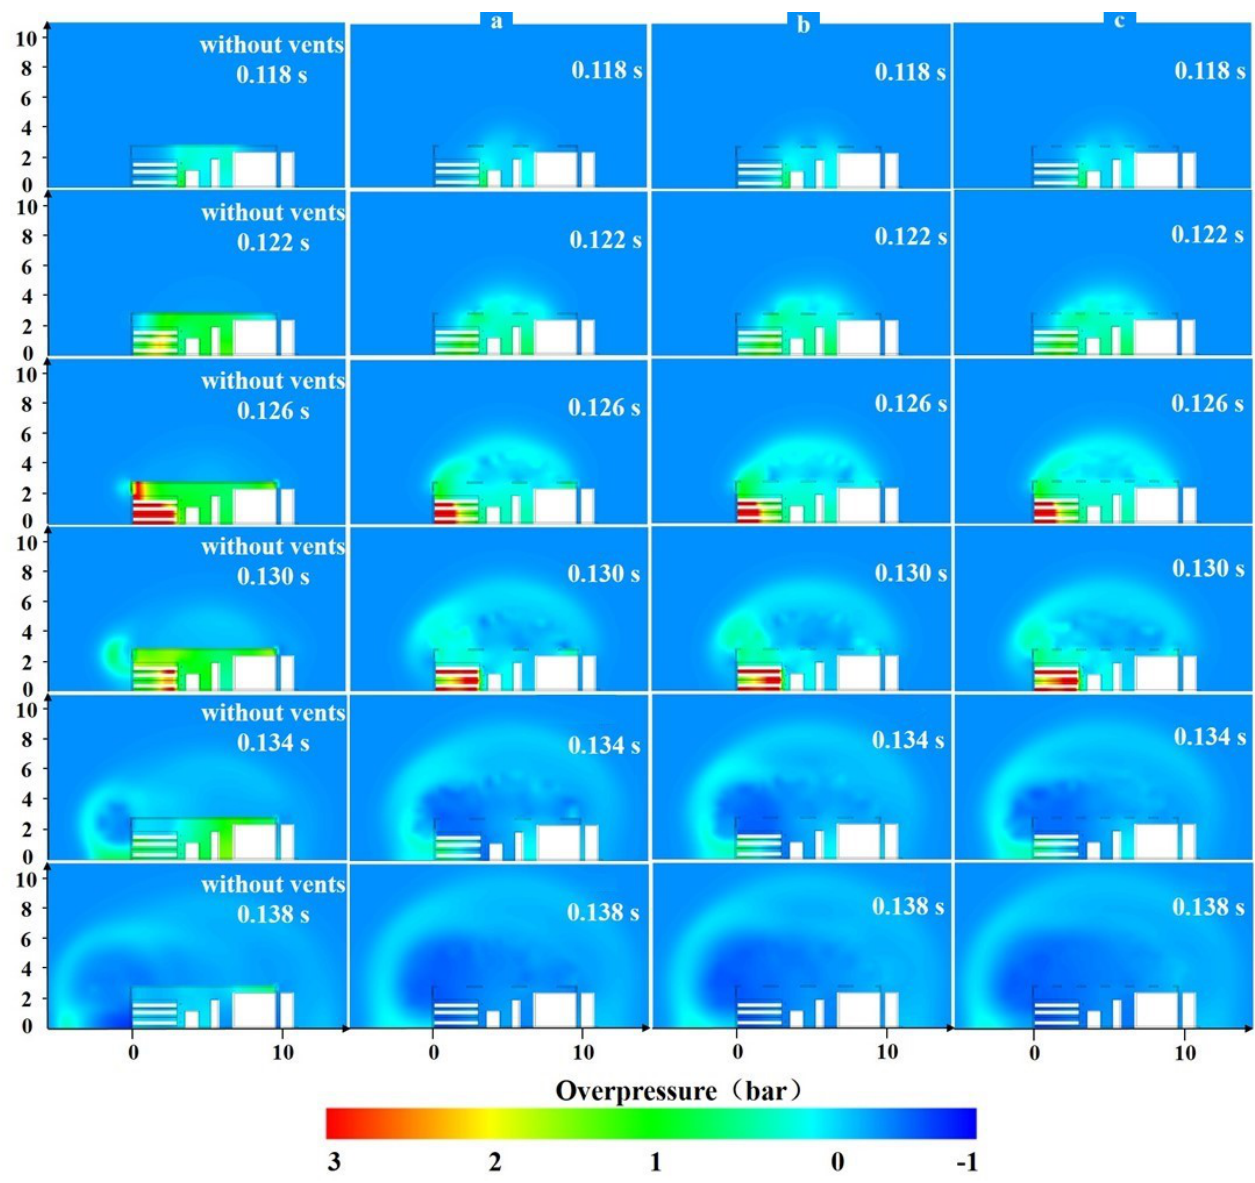
Figure 7. Overpressures at various times for various explosion vent layouts ( a – c ). The evolution of the hydrogen overpressures for various explosion vent layouts inside the container is shown in Figure 8a. The maximum overpressure inside the container without the explosion vents was 1.78 bar, which would cause severe damage to people and equipment inside the container. The explosion venting reduced the maximum overpressure inside the container by 61.83%, but the people and equipment inside the container would suffer serious overpressure injuries. The evolution of the hydrogen overpressures for various explosion vent layouts outside the container is shown in Figure 8b. The maximum pressure outside the container without the explosion vents was 0.91 bar, which would cause serious injuries to the nearby people and facilities. The explosion venting reduced the maximum overpressure outside the container by 29.07%, but the people and facilities outside the container would still suffer serious overpressure injuries. The overpressure curve of the three different vent layouts approximately overlaps; hence, the explosion vent layouts do not affect the explosion venting